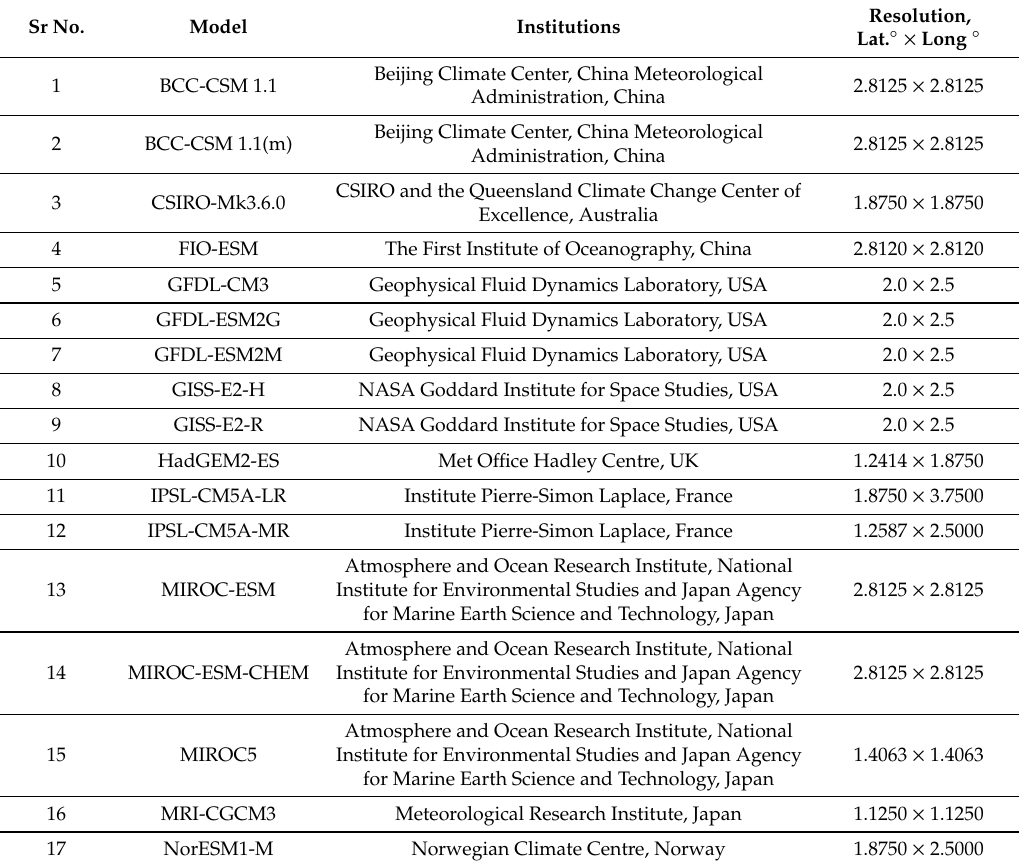
Table 1. Detailed description of the general circulation models (GCMs) used in the study. Institutions from Jones